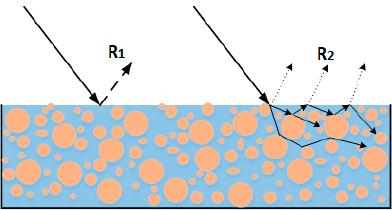
Figure 1. Illustration of the interaction between the incidence light and wetted sand. The path R 1 denotes the light directly reflected from the surface water film of saturated sand. Path R 2 demonstrates the remaining light that is transmitted through the water surface and subject to reflection from sand grains and absorption by